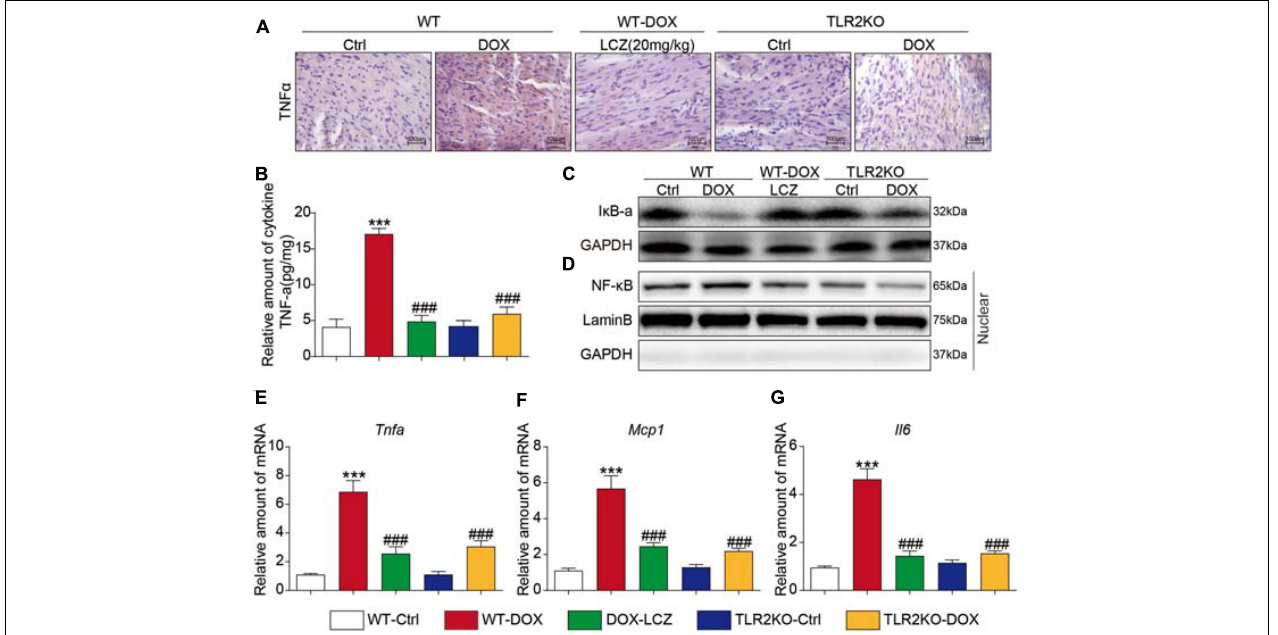
FIGURE 3 | LCZ696 treatment and TLR2 knockdown attenuated doxorubicin-induced cardiac inflammation in mice. (A) Representative images of anti-TNF- α staining in the hearts of each group (200 × ). (B) TNF- α levels in mouse heart tissue homogenates determined by ELISA. (C) Western blot analysis of I κ B α levels in heart tissue. GAPDH was used as a loading control. (D) Nuclei were isolated from mouse heart tissue, and NF- κ B in the nucleus was detected by western blot. Lamin B and GAPDH were used as controls. (E–G) Real-time PCR was used to determine the mRNA levels of Tnfa (E) , Mcp1 (F) , and Il-6 (G) in mouse heart tissue (data were normalized to Actb ). ( n = 7; *** P < 0.001 vs. WT control group; ### P < 0.001 vs. DOX